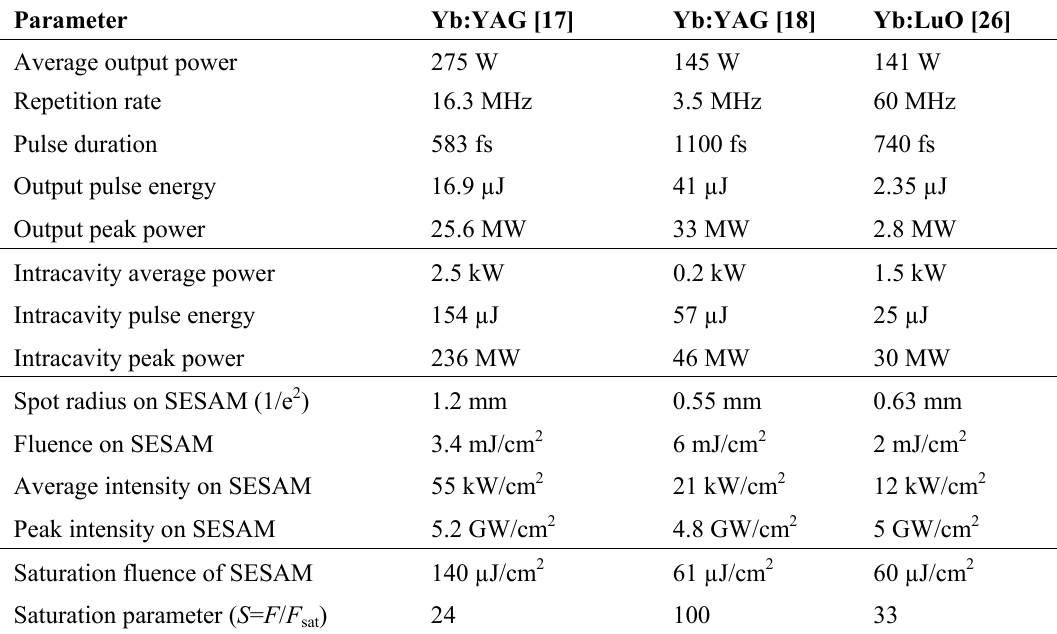
Table 2. Typical operation parameters of SESAMs in state-of-the-art high-power TDLs. Parameter Yb:YAG [17] Yb:YAG [18] Yb:LuO [26] Average output power 275 W 145 W 141 W Repetition